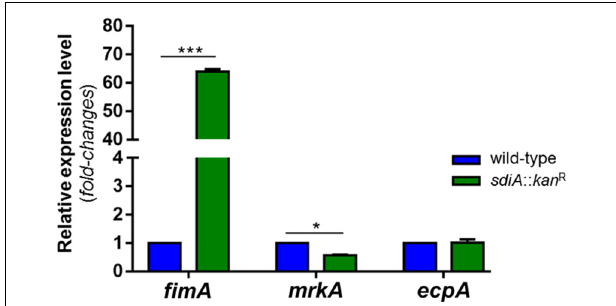
FIGURE 4 | K. pneumoniae deprived of SdiA presents up-regulation of fimA (type 1 fimbriae) and down-regulation of mrkA (type 3 fimbriae). No change in the expression of ecpA (common pillus) was observed between the wild-type and mutant strains. The expression of the genes was analyzed by RT-qPCR on the wild-type and mutant K. pneumoniae strains cultured at O.D. 600nm of 0.6. Error bars represent the standard deviation. Statistically significant differences between the strains were analyzed by multiple t -test (* p < 0.05; *** p <